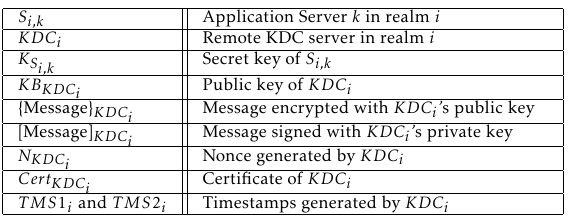
Table 5. The Additional Notation Needed In Multiple Remote Realms